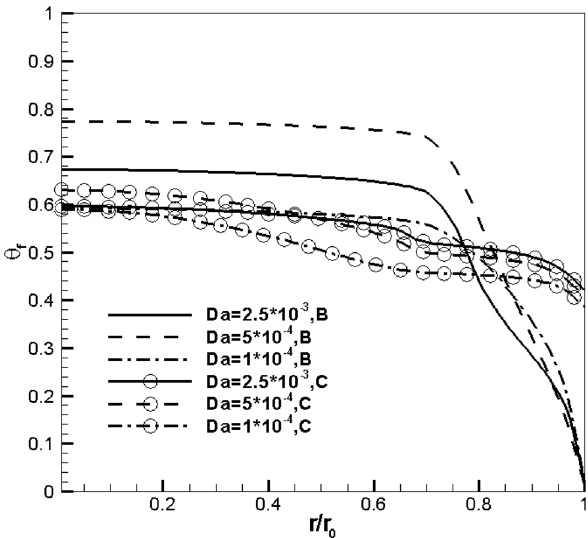
Fig. 7 Variation of non-dimensional temperature with Da for boundary (B) and central (C) arrangements